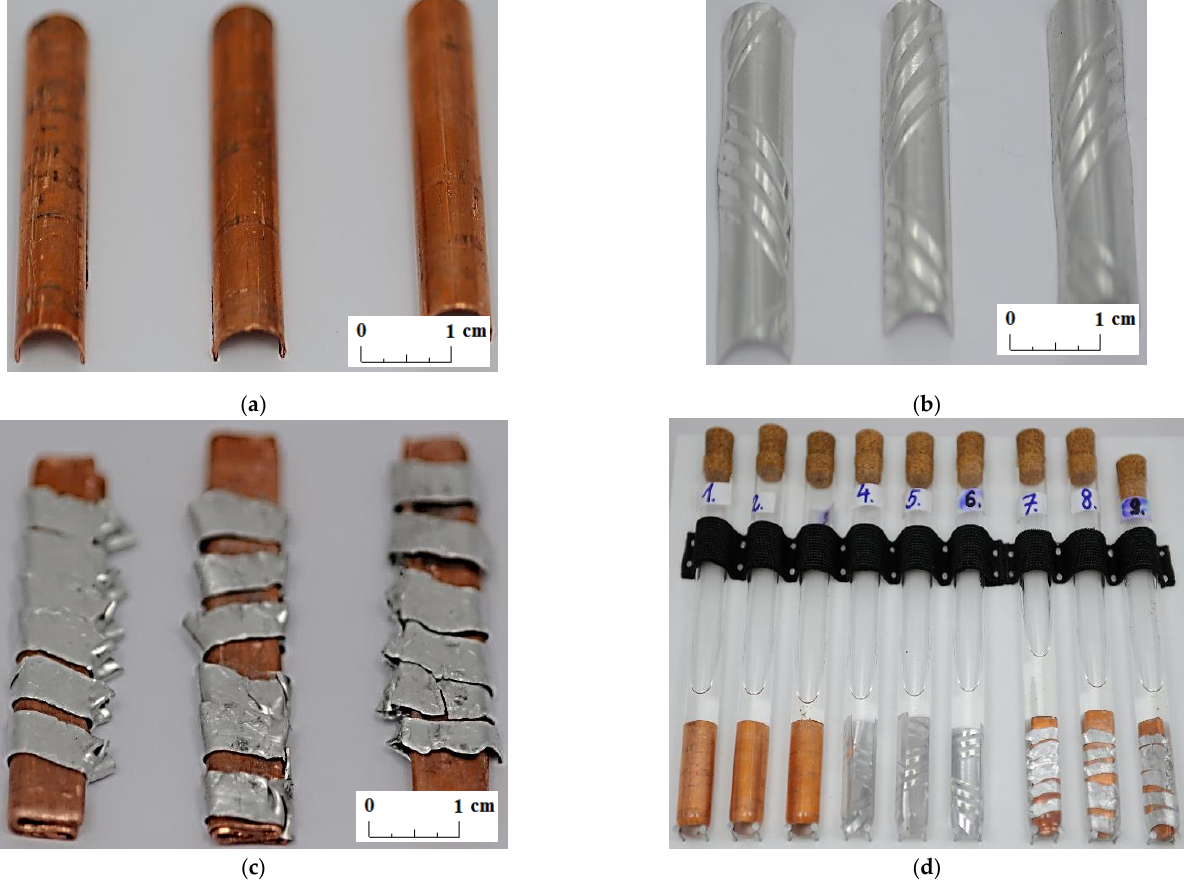
Figure 1. Tests samples: ( a ) copper; ( b ) aluminum; ( c ) combination of copper and aluminum; and ( d ) a view of all test samples placed in PCM tubes.